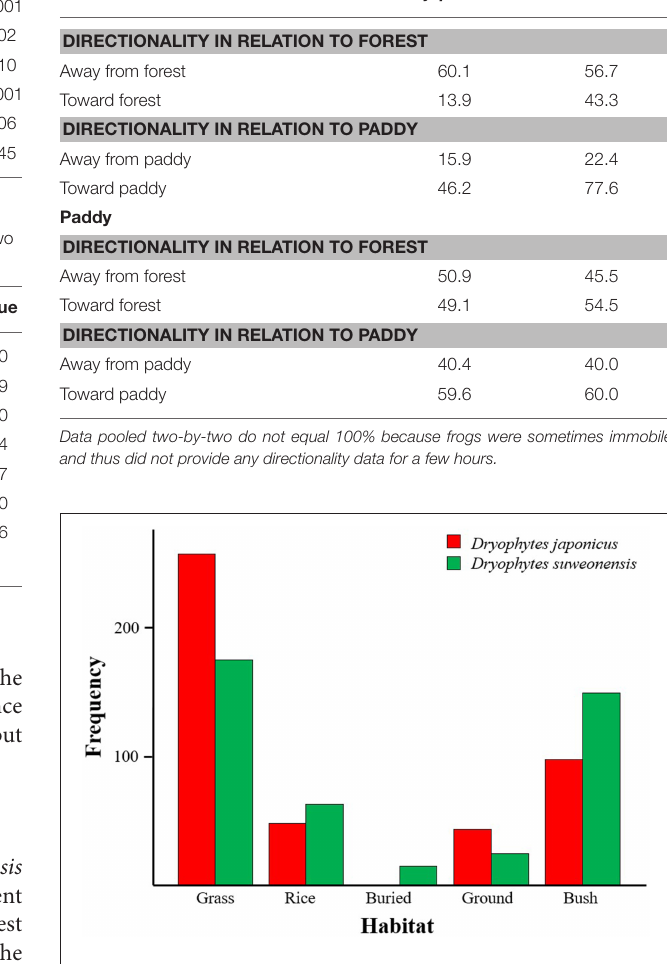
FIGURE 6 | Variations in habitat use between Dryophytes suweonensis and D. japonicus during the spring tracking experiments. Dryophytes japonicus was not found buried in this